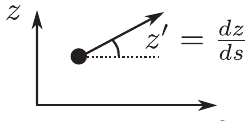
FIG. 1. Coordinate system. s points into the beam direction, z represents either the horizontal ( x ) or vertical ( y ) particle coor-